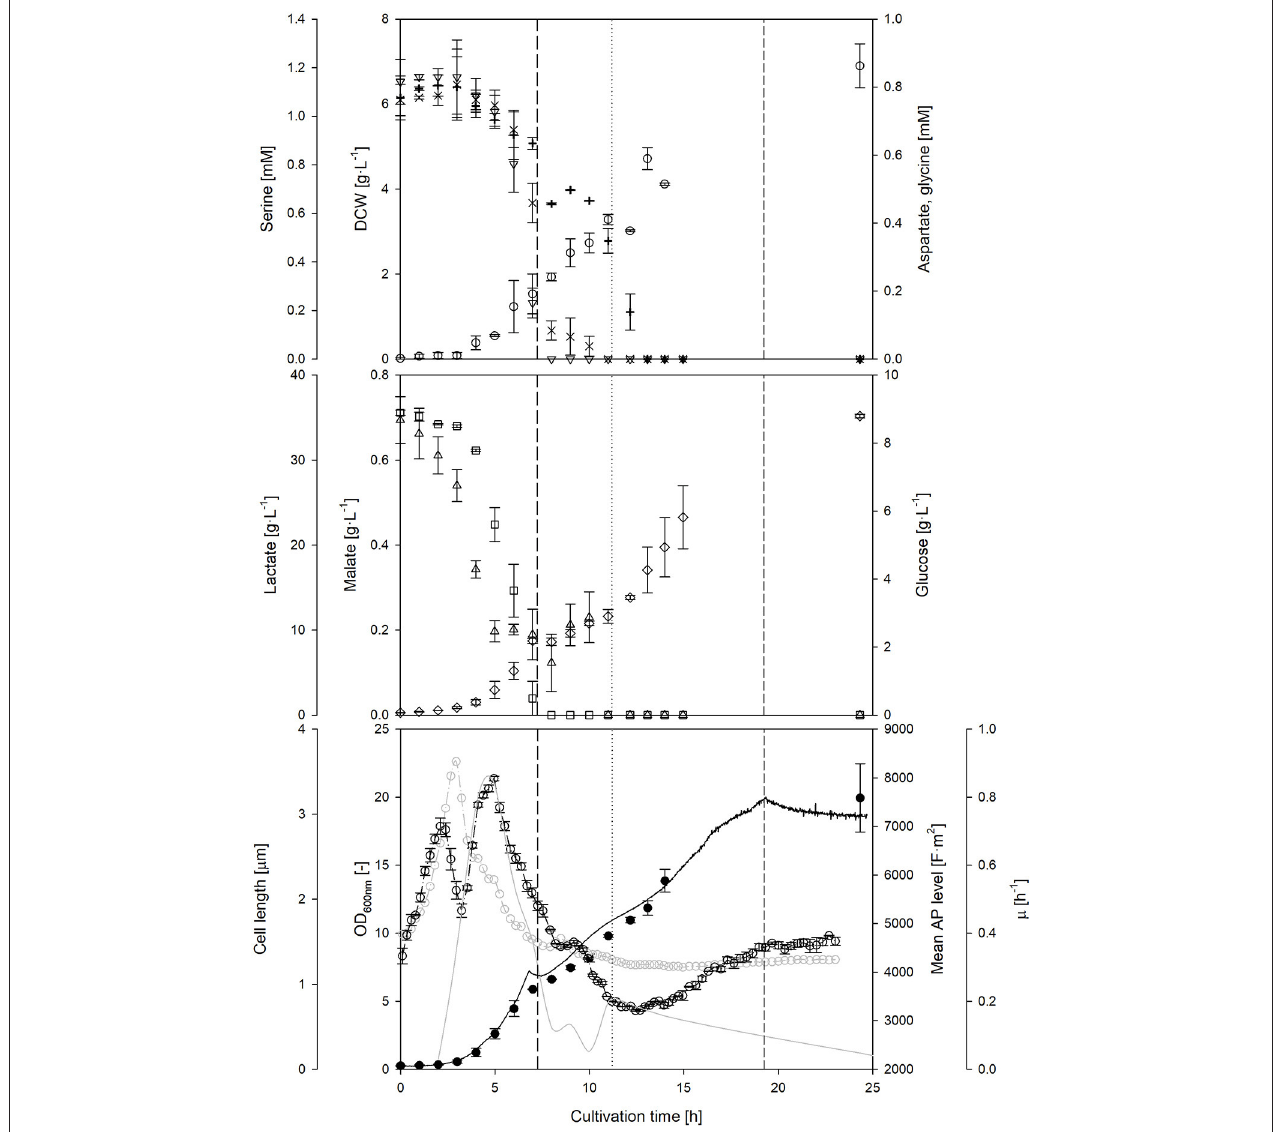
FIGURE 4 | Course of on-line and off-line cultivation parameters, as well as main metabolites and amino acids throughout a L. plantarum fed-batch cultivation under standard conditions. Off-line monitoring of DCW ( ◦ ), aspartate ( × ), serine ( ▽ ), glycine ( + ), glucose ( (cid:3) ), lactate ( ♦ ) and malate ( △ ) concentrations over time. At-line optical density (– • –), cell length (– ◦ –), mean polarizability (- − · ◦ − · -) and growth rate (–––––) measurements. During the fed-batch phase, the feed start (————), doubling of feed rate (........) and feed stop (-------) are highlighted with vertical lines. Error bars denote standard deviation of two biological replicates.